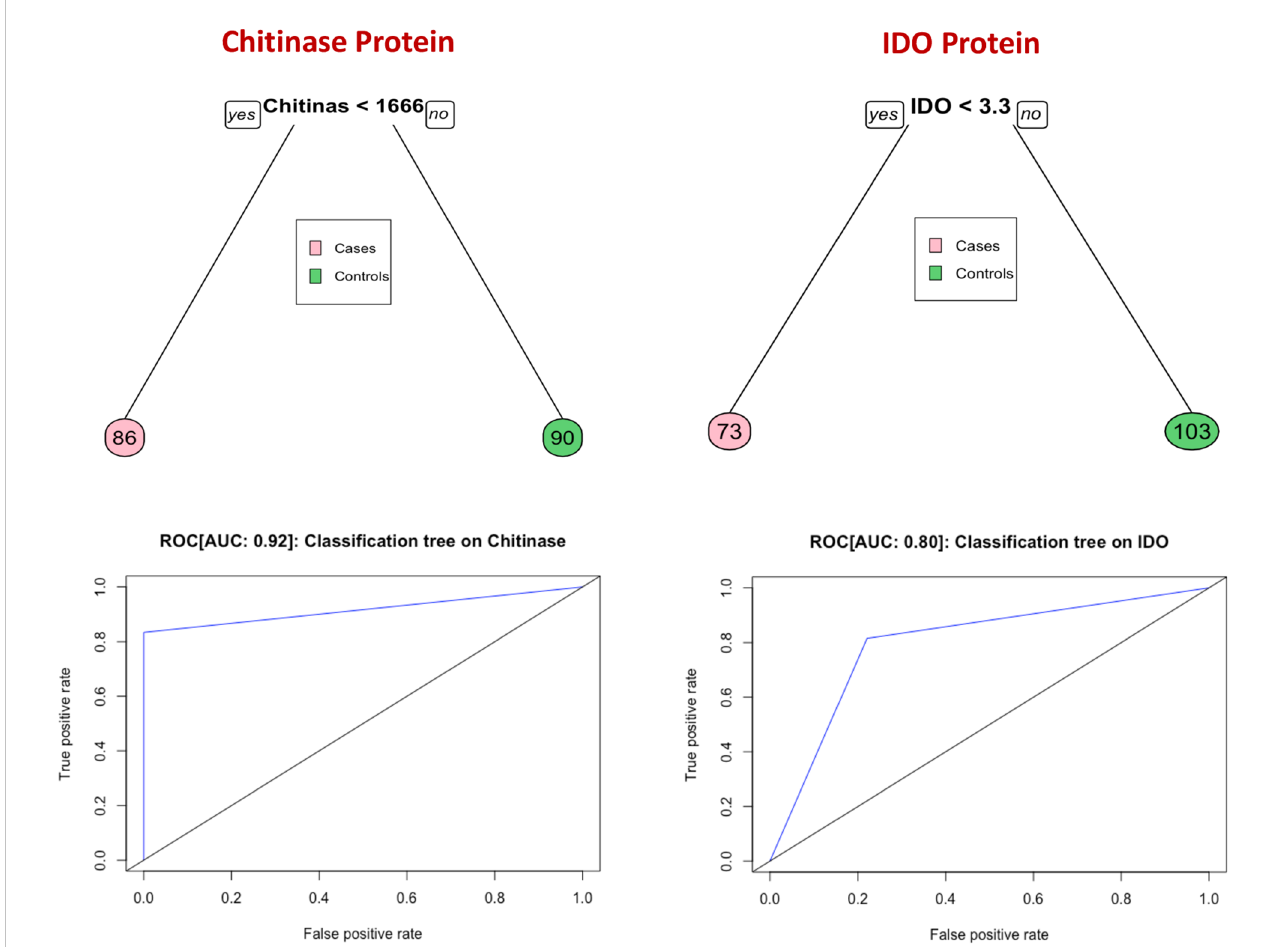
FIGURE 4 Identi fi cation of biomarkers showing the strongest associations with bad treatment outcome in TB disease. CART model analysis shows that chitinase protein and IDO protein exhibited the highest accuracy in discriminating cases from controls and ROC curves were employed to quantify the accuracy of biomarkers Cut-off value of chitinase protein and IDO protein is determined by this